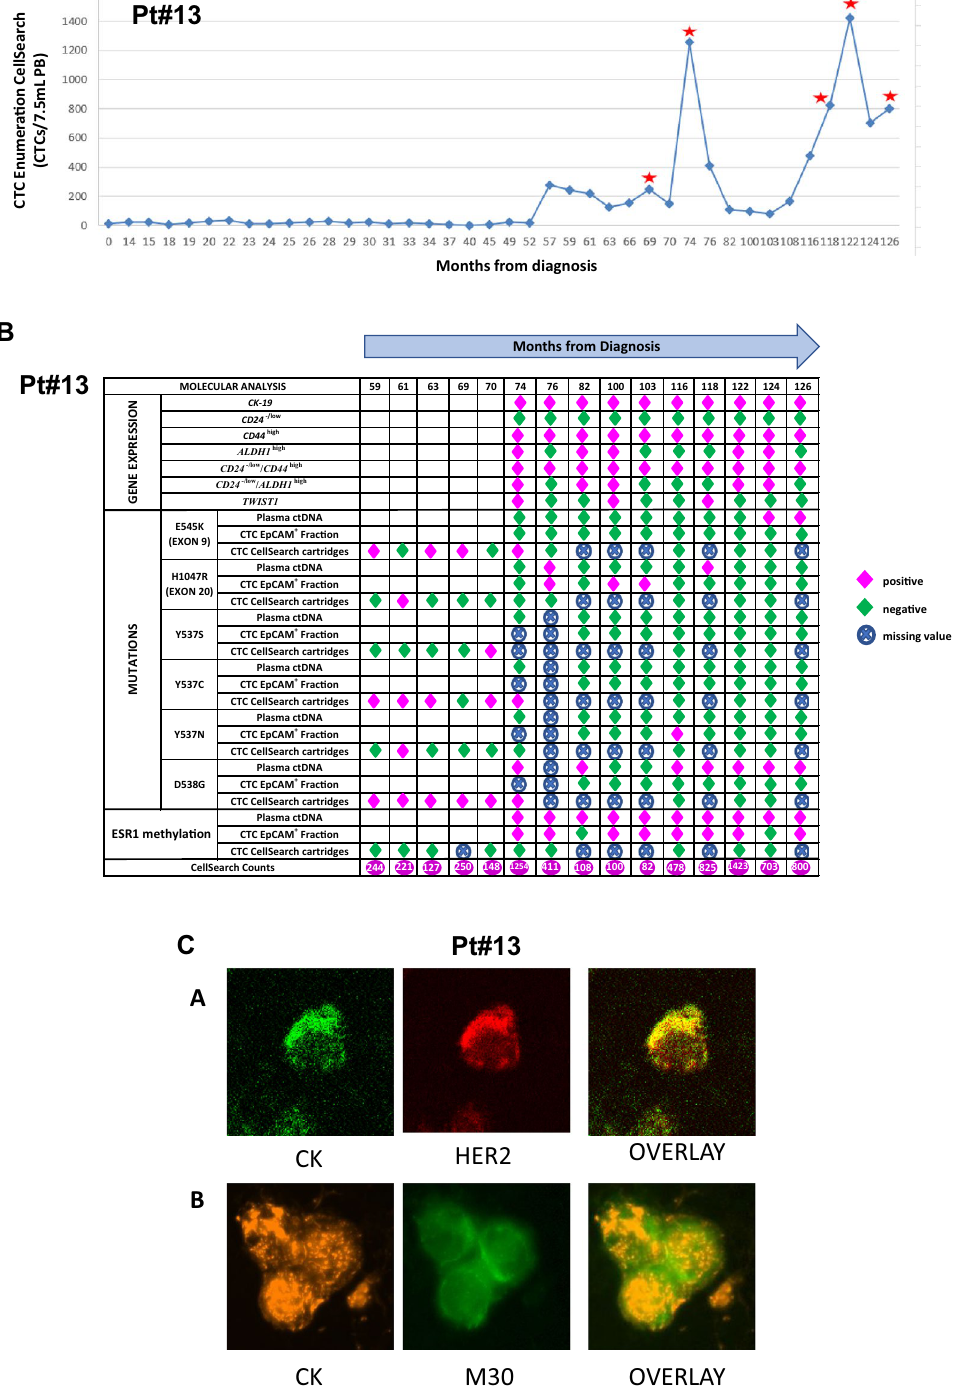
Figure 4. P#13: ( A ) CTC enumeration values (CTCs/7.5 mL PB) based on CellSearch, during the timeline of the disease (red stars represent the time of progression disease). ( B ) Molecular analysis of EpCAM (+) CTC fractions and CTCs from CellSearch cartridges for gene expression, PIK3CA and ESR1 mutations and ESR1 methylation, and corresponding plasma ctDNA (purple: positive, green: negative, crossed circle: missing value). ( C ) Representative images of CTCs by immunofluorescence experiments and confocal laser scanning microscopy